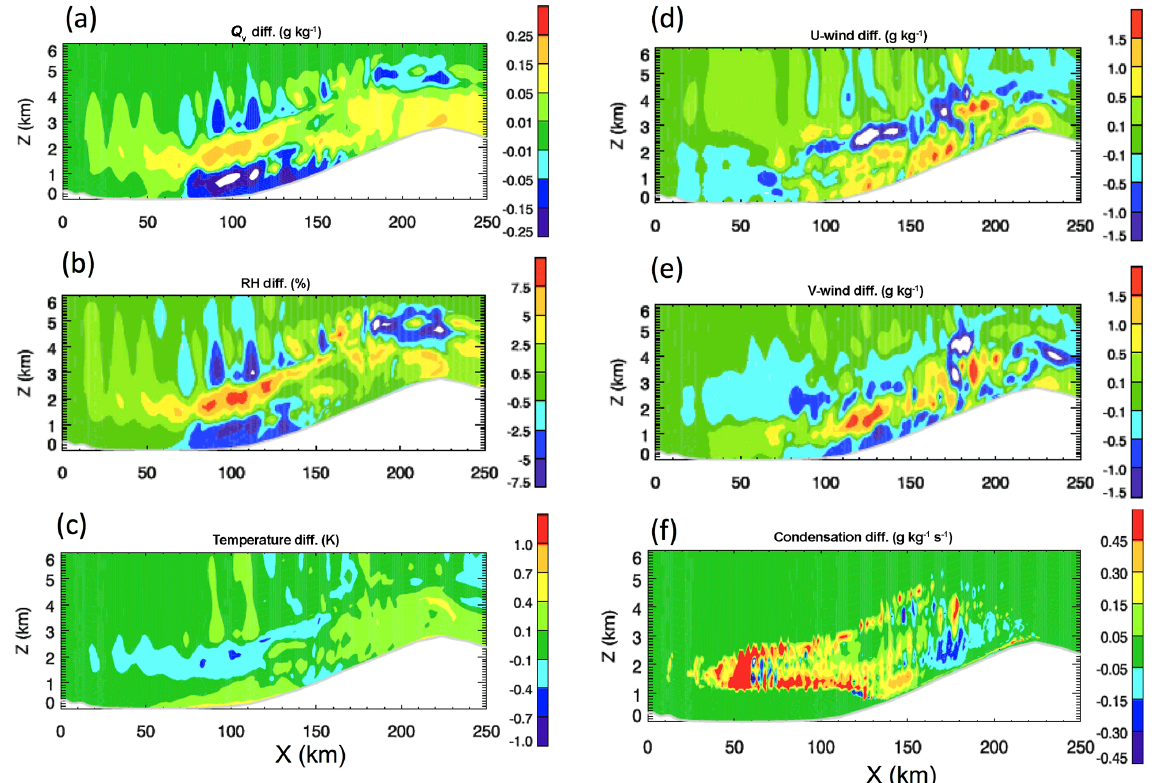
Figure 9. Differences in (a) water vapor, (b) RH, (c) temperature, (d) U component of the wind, (e) V component of the wind, and (f) condensation rate between CCN3000 and CCN30 with an INP proxy concentration of 1cm − 3 for the CMOC. The cross section area is the same as Fig. 8. The time is at 14:00UTC except that the condensation rate used for the difference calculation is the sum of that from 13:00 to 14:00UTC to show an accumulated value over a 1h period before